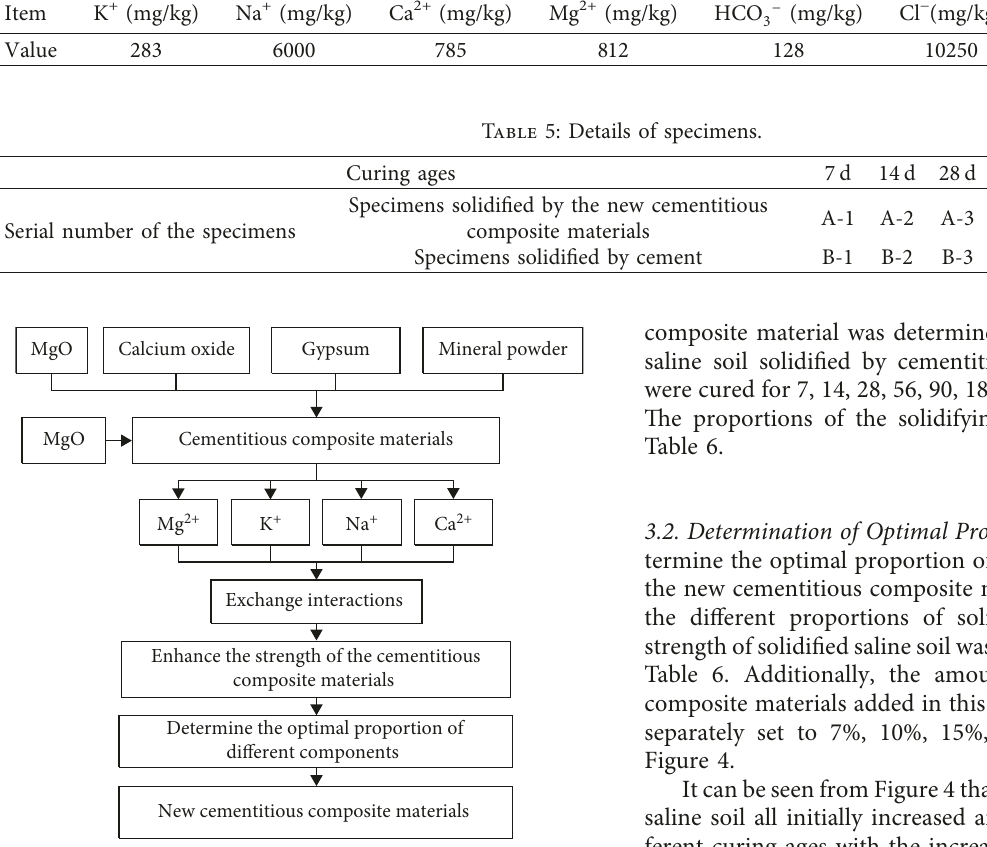
Figure 3: Schematic diagram for the improvement